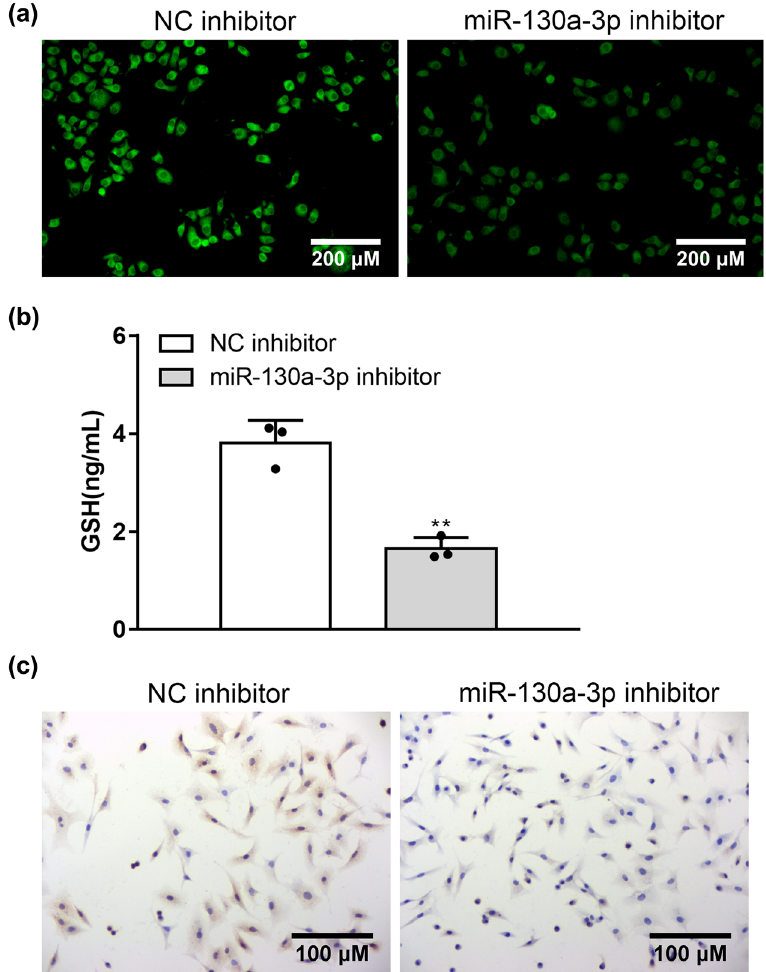
Figure 3: miR - 130a - 3p inhibitor suppressed oxidative stress of neurons under the HG condition. ( a ) Impacts of miR - 130a - 3p inhibitor on ROS level of HG - treated neurons were detected by DCF probe using a commercial kit ( bar = 200 μ m ) . ( b ) Impacts of miR - 130a - 3p inhibitor on the GSH level of HG - treated neurons. ( c ) Photographs show Nav1.8 channel expression in neurons ( bar = 100 μ m ) . ** P < 0.01 vs NC